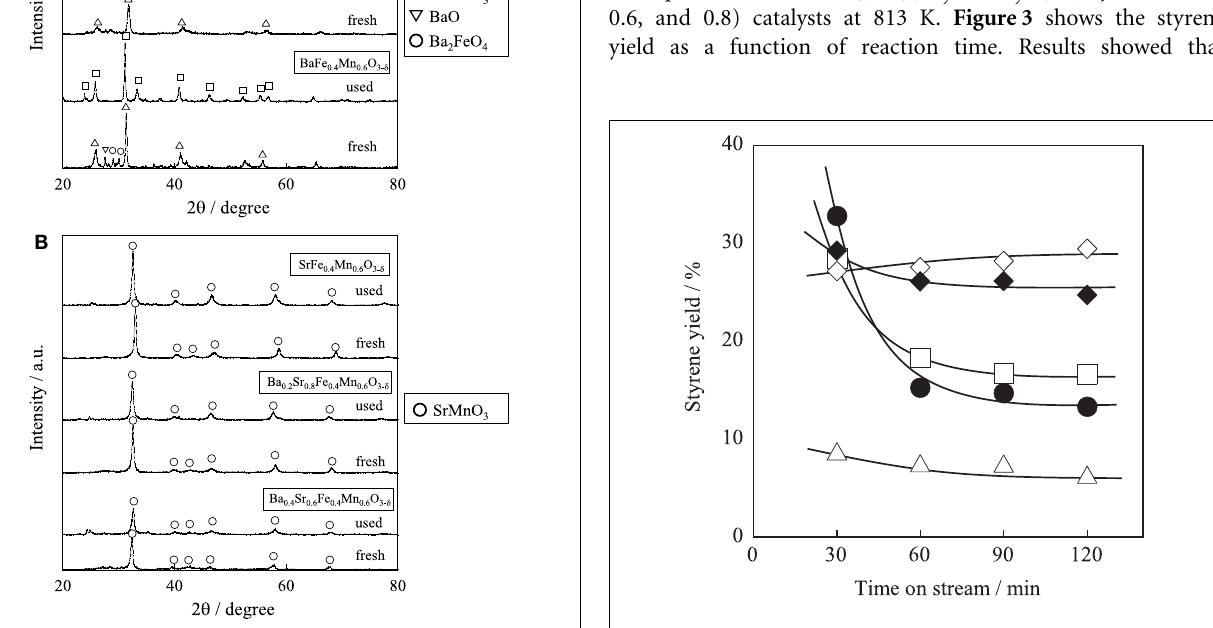
FIGURE 3 | Effect of Fe cation substitution ratio in Ba 0 . 4 Sr 0 . 6 Fe y Mn 1 − y O 3 − δ catalyst on styrene yield: ( • ) y = 0 . 2, ( (cid:2) ) y = 0 . 4, ( (cid:3) ) y = 0 . 6, ( (cid:4) ) y = 0 . 8, and ( ♦ ) Fe–K